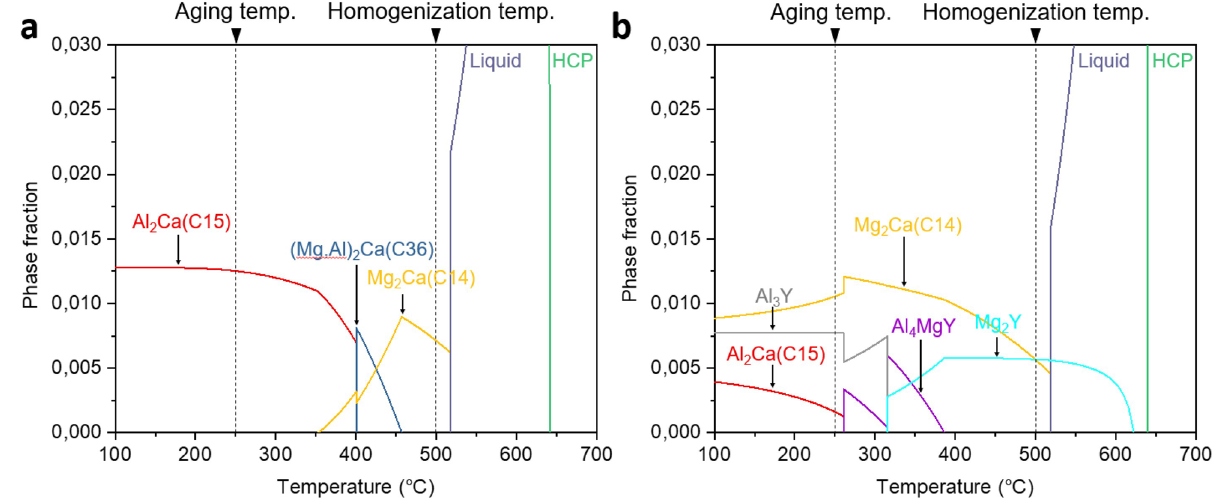
Figure 7. Equilibrium phase fraction of the AX10 and AXW100 alloys calculated using thermodynamic calculation software Pandat 37 .